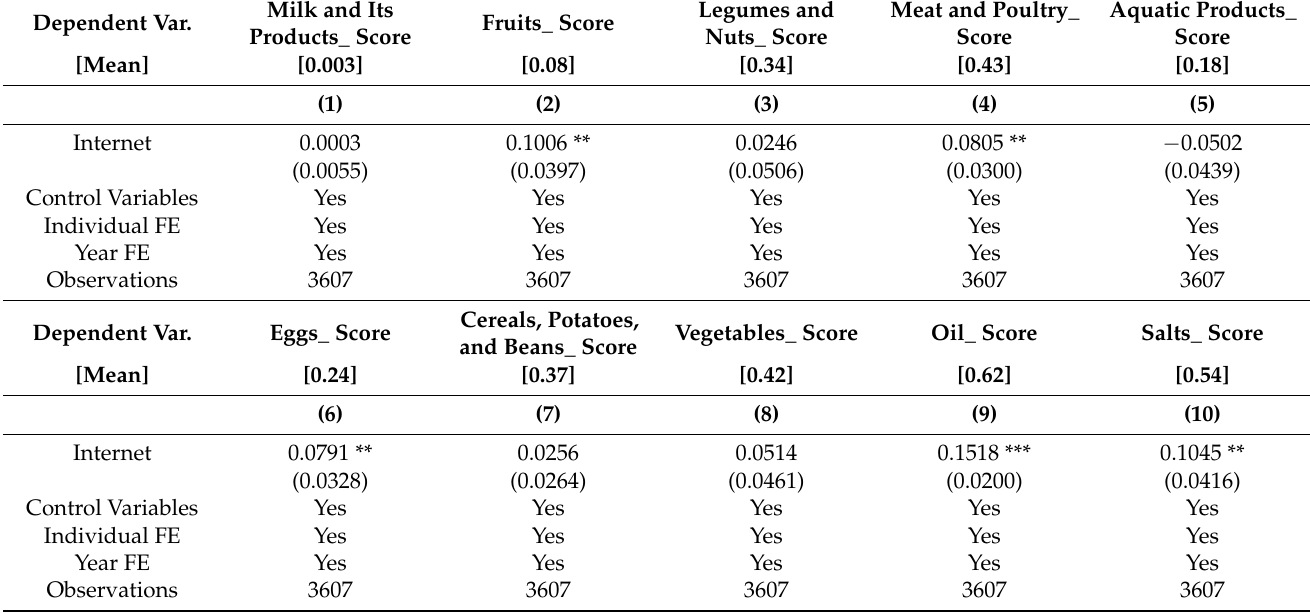
Table 3. Internet use effects on dietary quality scores of rural adults for various food groups.